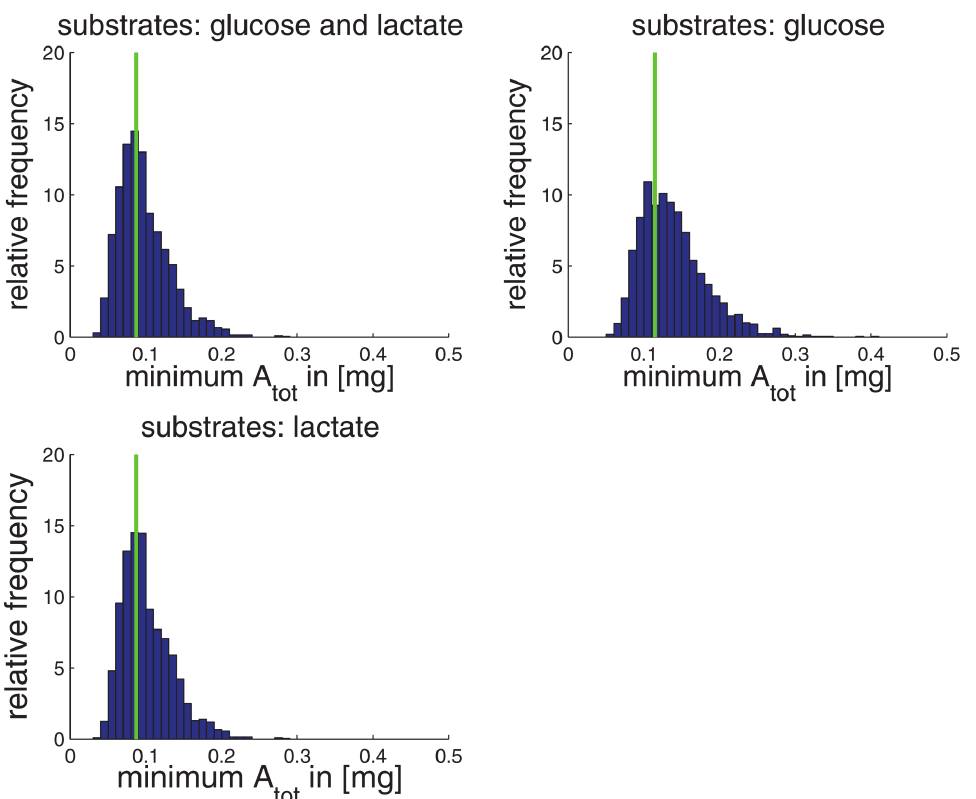
Fig 7. Impact of variations in the enzyme expression efficiencies on the minimal total amino acid mass A tot required to produce the metabolic output within 8h in the base condition (all genes active, no switch). The frequency distributions are the outcome of 2000 computations of A tot where the values of the expression efficiencies were sampled from the lognormal distribution η j * ln N (0, 0.36 2 ). The unperturbed values, i.e., η j = 1 for all reactions j , are marked in